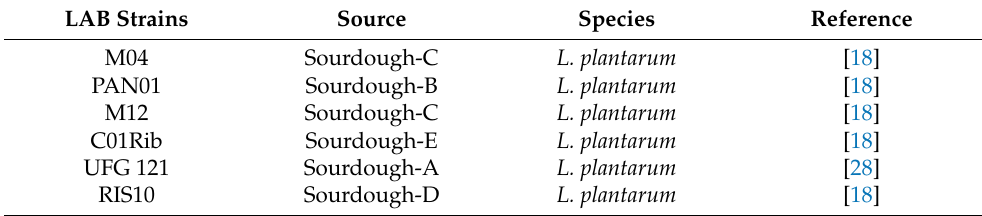
Table 1. The six lactic acid bacteria (LAB) strains with best antifungal activity against B. cinerea .